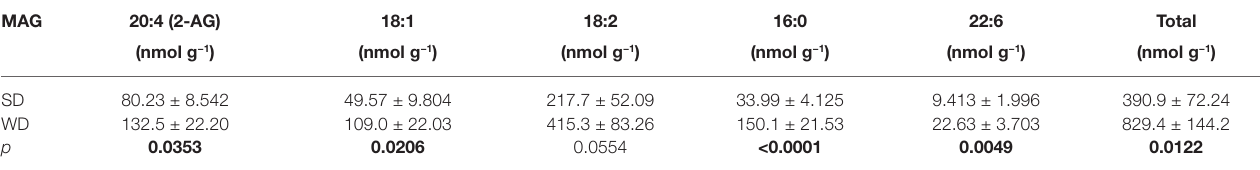
MAG, Monoacylglycerol represented as fatty acid chain; SD, Standard diet n = 10; WD, Western diet n = 9. Mean values are shown as ± S.E.M. Bold values are significantly different determined by two-tailed unpaired